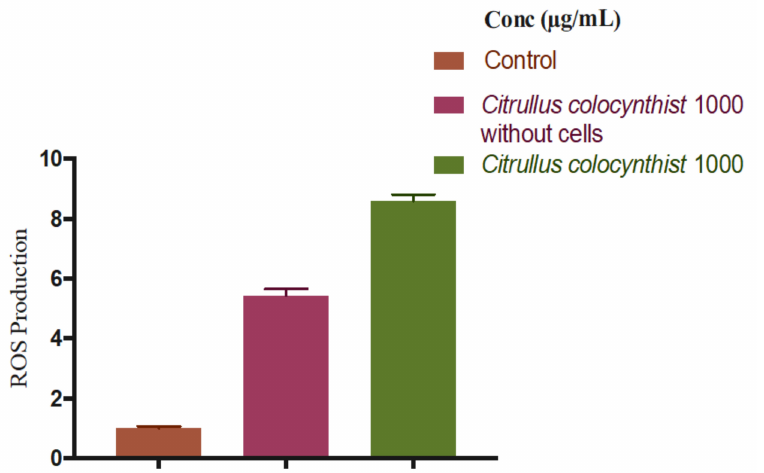
Figure 7. ROS production comparison of the Citrullus colocynthist extract control without cells compared to with cells and to the control (mean ± S.D.). The results were obtained through three independent